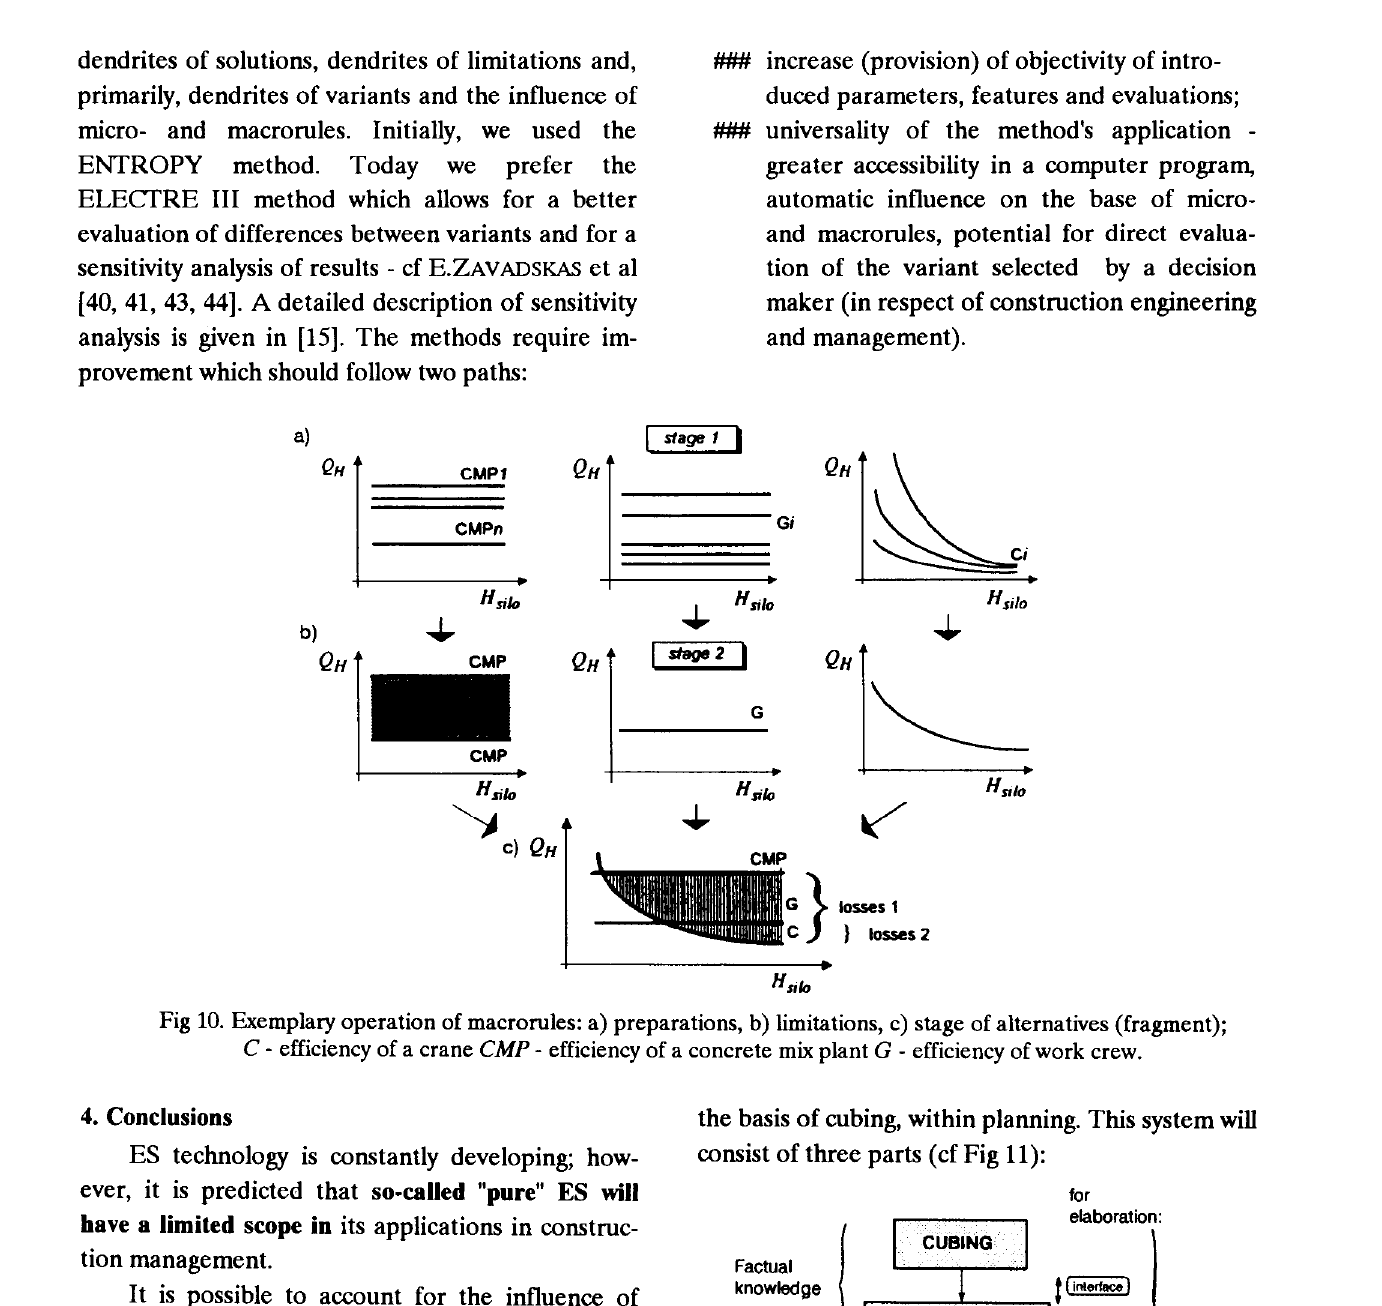
Fig 10. Exemplary operation of macrorules: a) preparations, b) limitations, c) stage of alternatives (fragment); C- efficiency of a crane CMP- efficiency of a concrete mix plant G - efficiency of work crew.